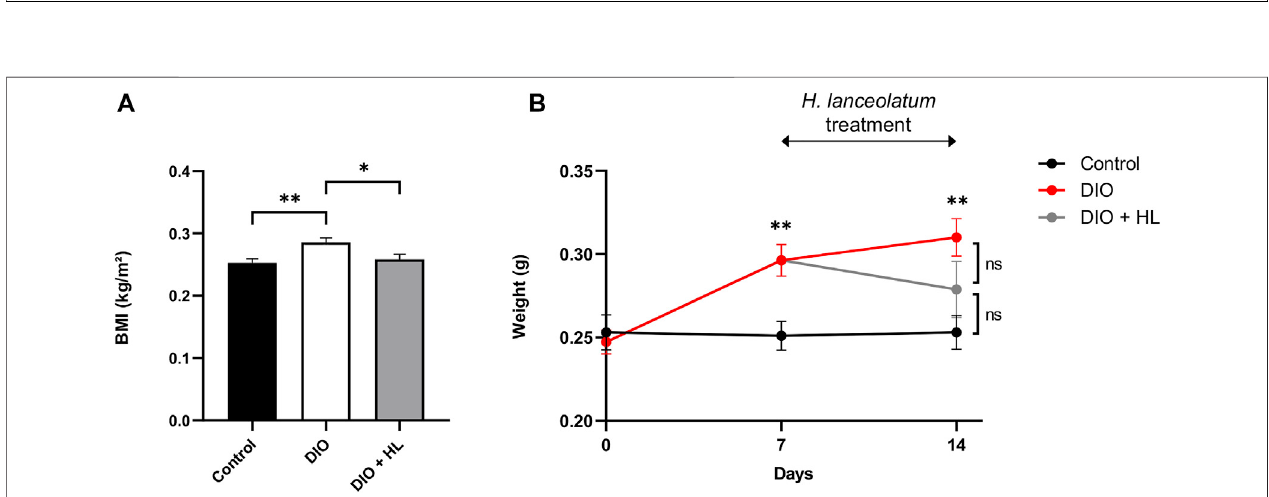
FIGURE11| H.lanceolatum aqueousextractinducesweightlosspropertiesinDIOmodelofadult fi sh. (A) Bodymassindex(BMI)atday-14and (B) bodyweightof normally fed (Control), overfed (DIO) and overfed fi sh treated with H. lanceolatum (DIO + HL). Results are expressed as means ± SEM ( n = 8 – 10/group). * p < 0.05, ** p < 0.01 (One-way